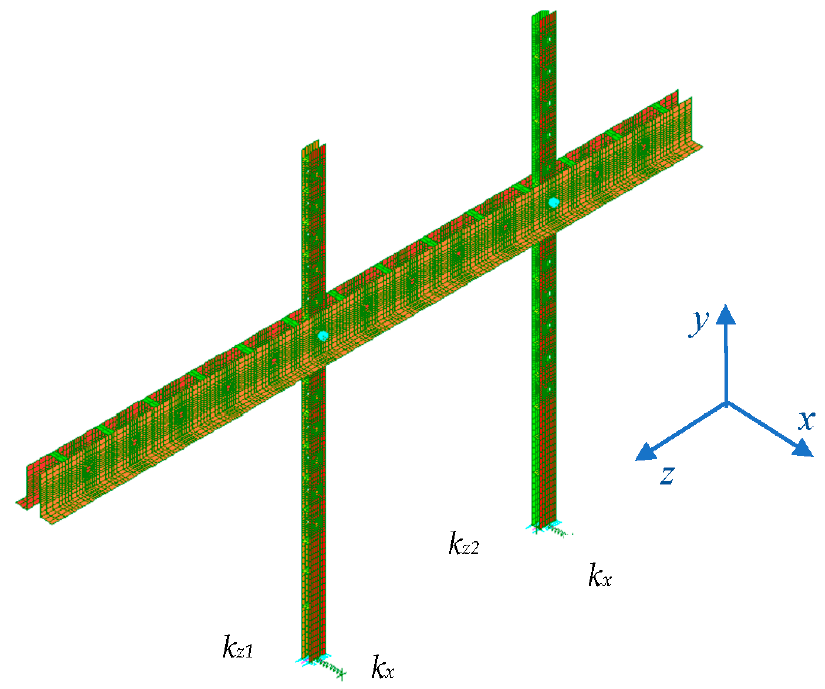
Figure 14. Finite element model of the steel frame in the configuration adopted during the tests.